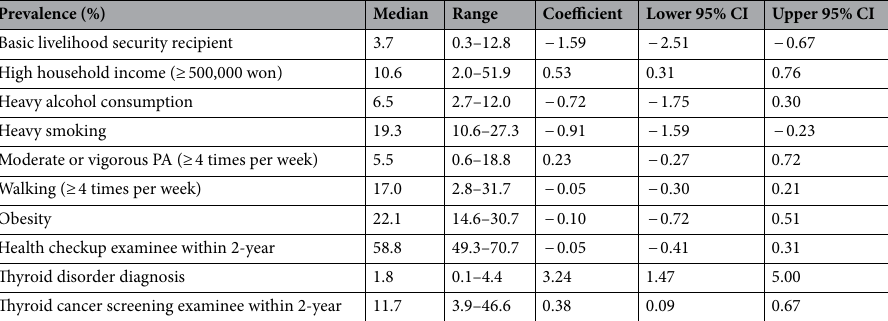
Table 2. Association between regional characteristics and age standardized incidence rates of thyroid cancer from 2009 to 2013 in Korea. Heavy alcohol consumption indicates alcohol consumption ≥ 4 times a week. Heavy smoking indicates smoking ≥ 20 cigarettes per day. Obesity was defined as a body mass index of 25 kg/ m 2 . CI credible interval, PA Physical